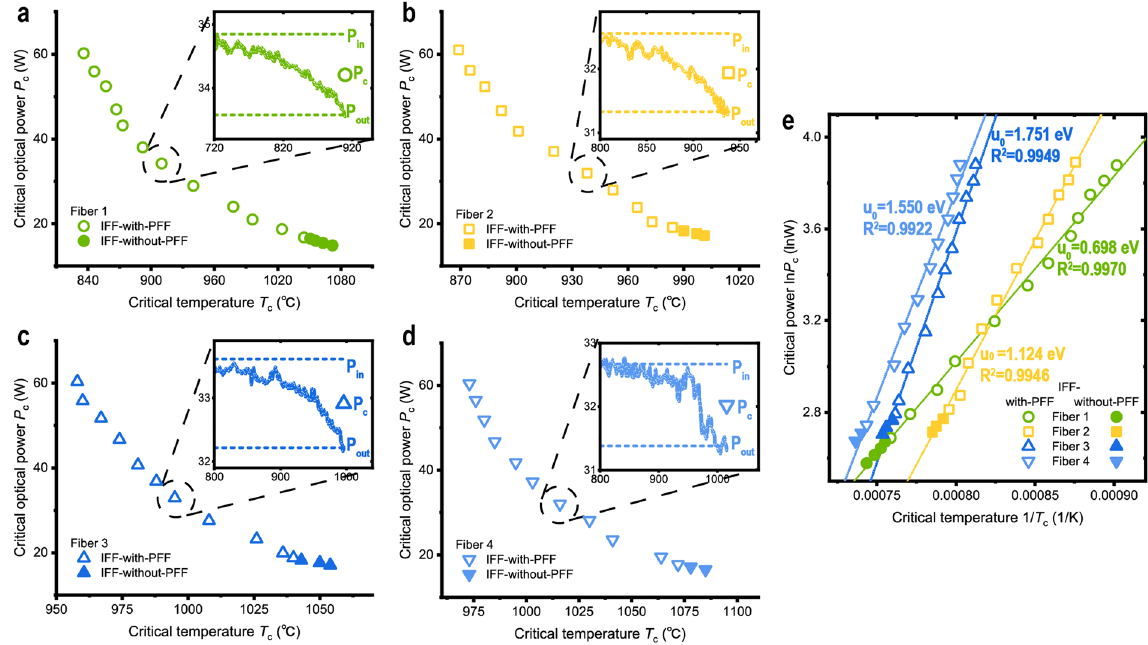
Figure 4. The critical optical powers P c varying with the critical temperatures T c for the IFF. Subplot ( a – d ) are P c versus T c (in °C) results of fibre 1–4, respectively. Insets are examples of the real-time output powers recorded while the temperatur e s were increasing. ( e ) linear correlation between P ln straight lines are the least-square linear fits and u 0 calculated by Eq.